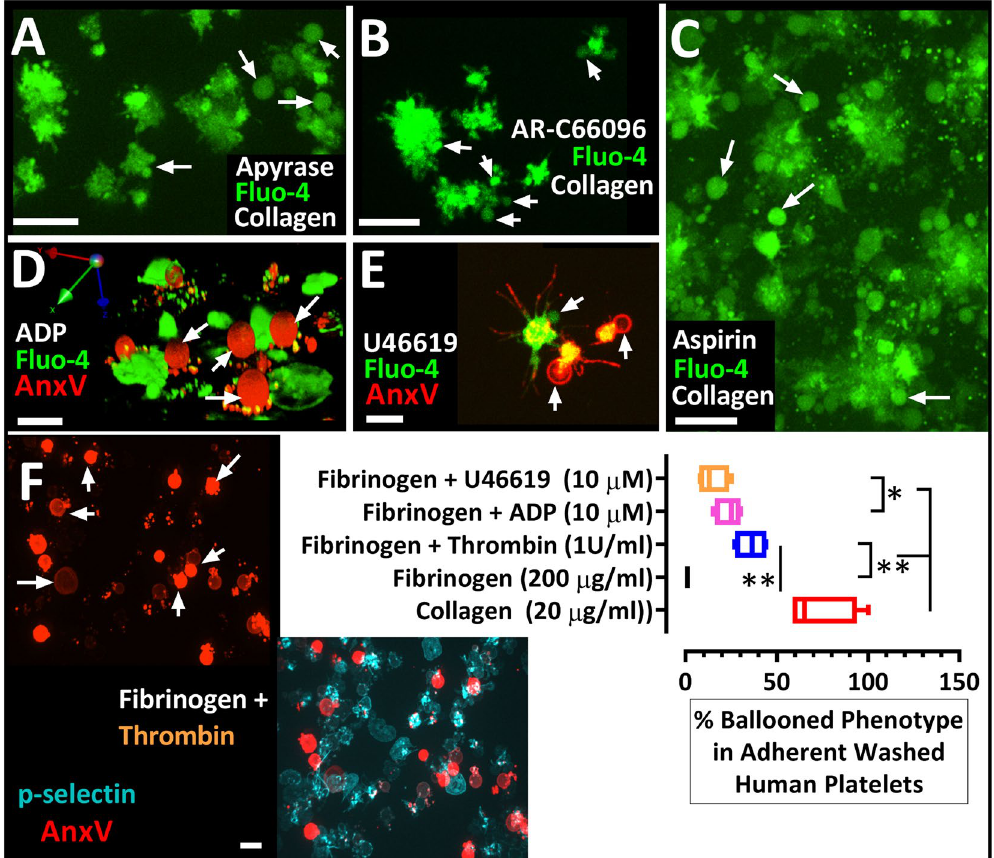
Figure 6. Thrombin-mediated synchronised ballooning is unaffected by ADP and T X A 2 blockade. In ( A – C ) platelets in re-calcified platelet-rich-plasma were labelled with calcium dye Fluo-4 and pre-incubated with ( A ) Apyrase (1.5 U/ml), ( B ) AR-C66096 (0.1 µ M) and ( C ) Aspirin (10 µ M), and were allowed to adhere to a collagen-coated surface. Induction of synchronous membrane ballooning in platelet- rich-plasma is unaffected by ADP and T X A 2 blockade. White arrows point to ballooned platelets in the extended focus images ( A–C ). In ( D–F ), membrane ballooning was induced on fibrinogen-coated surfaces, by ADP, U46619 and thrombin in the presence of 1 mM extracellular calcium. In ( D , E and F ), 3D ( D ) and extended focus ( E , F ) images of AnxV (red) and Fluo-4 (green) or P-selectin (cyan) show ballooned and procoagulant-spread platelets (red) induced by ADP 10 µ M (D), U46619 10 µ M (E) and 1 U/ml thrombin (F). Images were acquired 1 hr after addition of ADP, U46619 and thrombin and the real-time monitoring of platelet aggregation. Chart in panel F show the percentage of ballooned platelets counted under these condition. Data analysis was by Friedman test, followed by Dunn’s multiple comparison test. * P < 0.0 5 was considered significant. Scale bar represent 5 µ m (D,E), and 10 µ m (A–C). Data were from 10–15 aggregates (of 7–40 platelets) per view; and 35 ± 5 aggregates were analysed for each of 5 donor blood